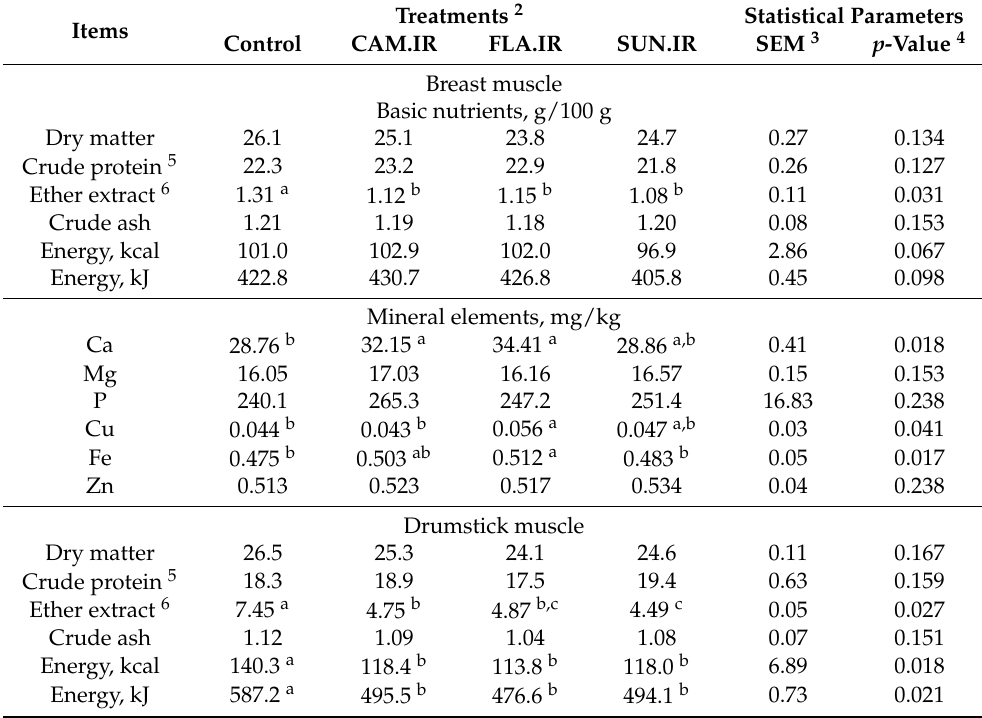
Table 4. Content of basic nutrients and mineral elements in natural matter in broiler chicken muscles 1